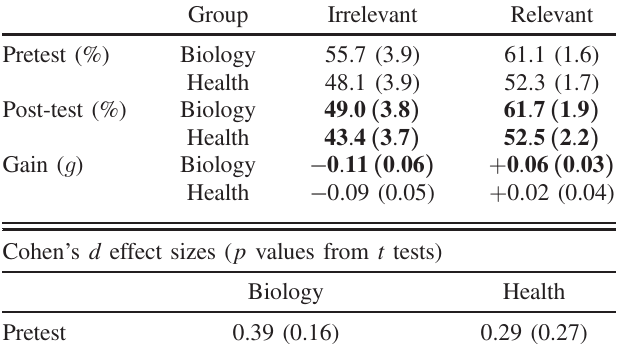
TABLE IV. Top: Average CLASS pretest and post-test per- centages of expertlike scores and normalized gains, comparing students who perceived relevance vs students who did not. Standard errors are in parentheses next to means; please see Table I for respective sample sizes. Bottom: Cohen ’ s d values and t -test p values for comparisons between relevant and irrelevant views. Adapted from Table 4 in Ref.